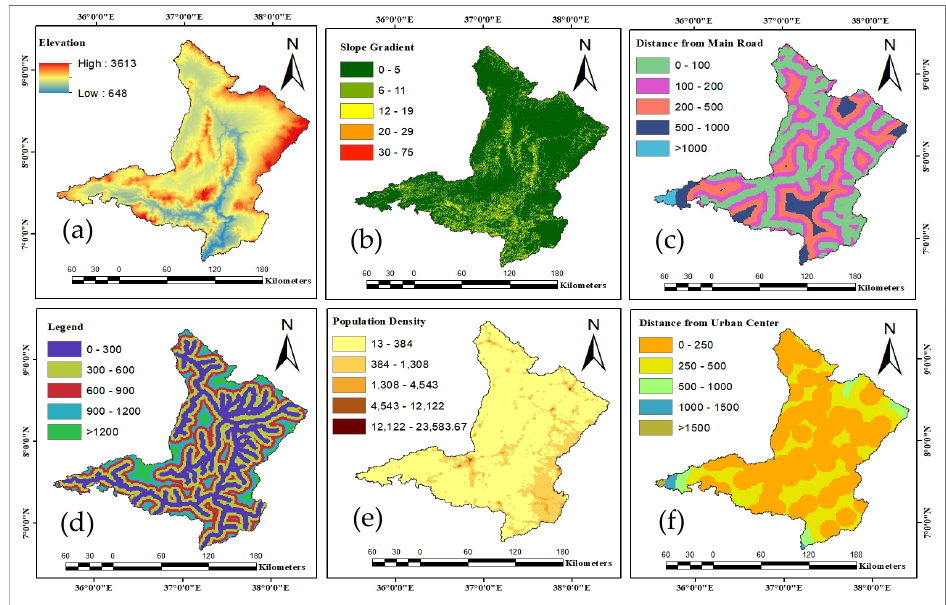
Figure 5. Spatial variables (explanatory variables): ( a ) elevation ( b ) slope gradient ( c ) distance from the main road, ( d ) distance from the streams, ( e ) population density, and ( f ) distance from the urban center.